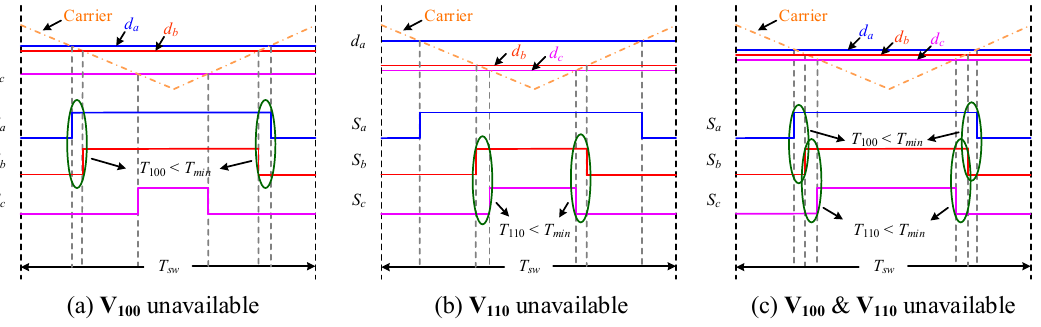
Figure 8. Three current sampling failure cases in Sector I, when ( a ) V 100 is not available ( b ) V 110 is not available ( c ) both V 100 and V 110 are not available.